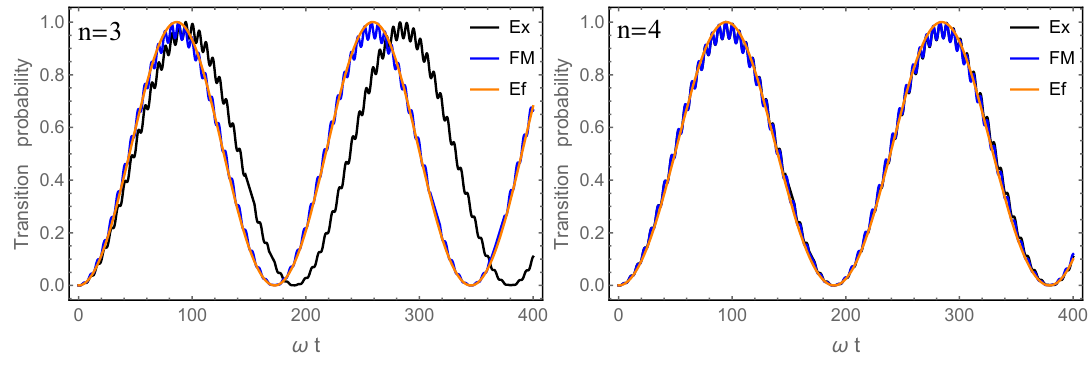
Figure 1. Transition probability for the three-lambda system with f ( t ) = e i ω t for ω = 10 ( 1 + obtained with Floquet–Magnus (FM) with n = 3 (left) and n = 4 (right) terms in the expansion. Blue line corresponds to FM, orange (Ef) line stands for the effective Hamiltonian H ef ≡ iF and black (Ex) line is the exact solution.